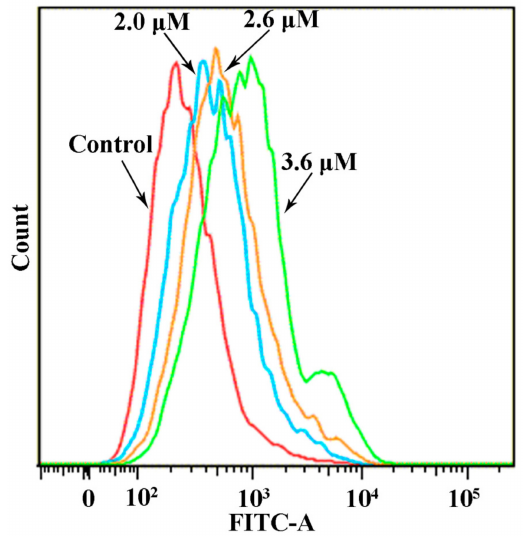
Figure 8. The effect of complex 1 (2.0, 2.6, and 3.6 µ M) on the intracellular free Ca 2+ level in MGC80-3 cells for 24 h.